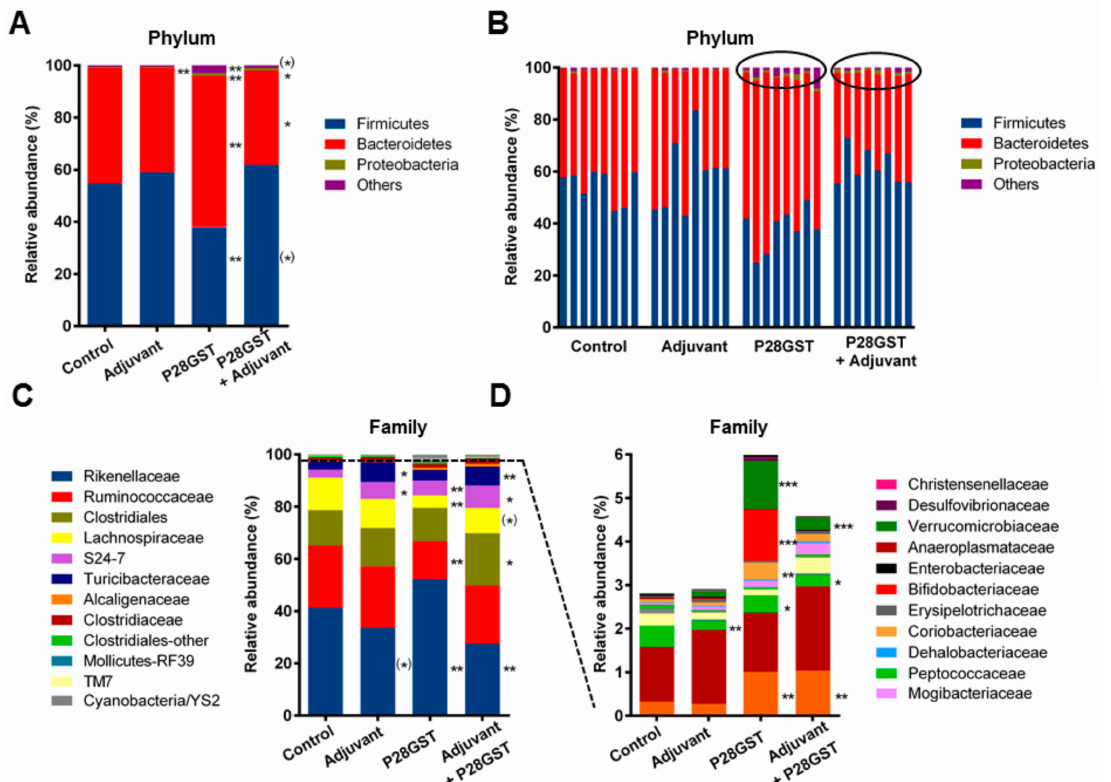
Figure 3. Immunizations of mice by Adjuvant, P28GST, and (P28GST + Adjuvant) induce slight changes in the composition of the fecal microbiota in comparison with saline as control. Data were generated by analysis of 16S rRNA gene sequences. ( A ) Mean relative abundance at the phylum level for each group of mice, n = 8 per group. ( B ) Individual relative abundance at the phylum level shows consistency of the e ff ects. ( C ) Mean relative abundance at the family level for each group of mice and ( D ) focus on the corresponding low-represented mean relative abundance at the family level (below 6%), n = 8 per group. Results are expressed as % of the total operational taxonomic unit (OTU) numbers. * p < 0.05; ** p < 0.01; *** p < 0.001; ( * ) 0.05 < p < 0.1 versus the control